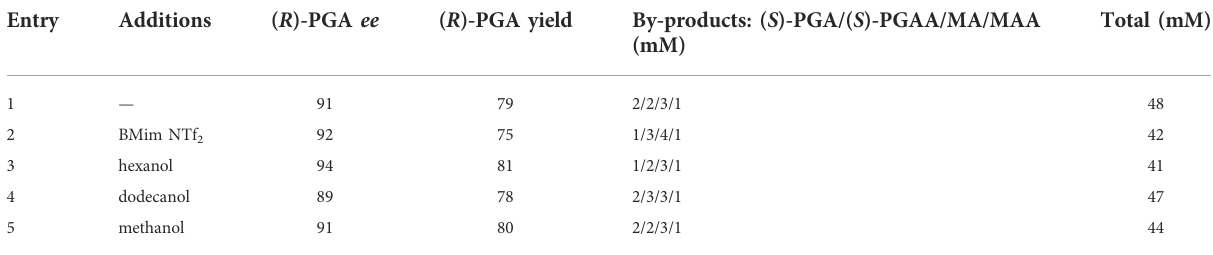
TABLE 2 Chemoenzymatic enantioselective synthesis of ( R )-phenylglycine from benzaldehyde, ammonia and KCN by a combination of a Strecker synthesis and a biotransformation using E. coli JM109 Δ pepA (pIK9/pap).